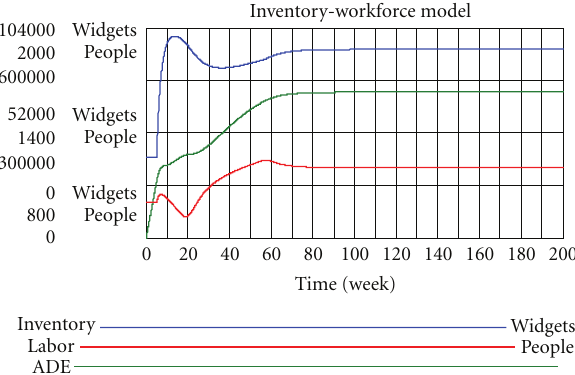
Figure 6: Behavior of state variables with policy that uses PSO